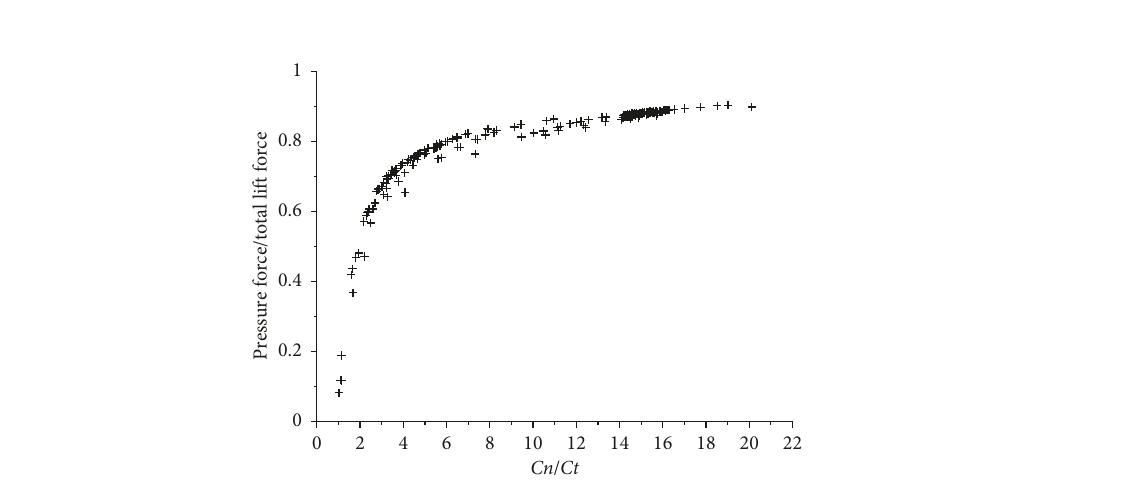
Figure 8: Evolution of Ct (a) and Cn / Ct (b) as a function Re Dh .